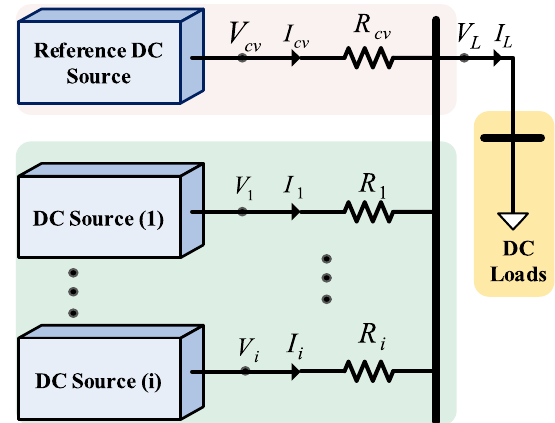
Fig. 1 General representation of a